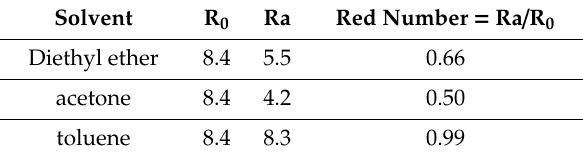
Table 8. Relative energy di ff erence (RED) of dimethyl sulfide for each organic solvent.